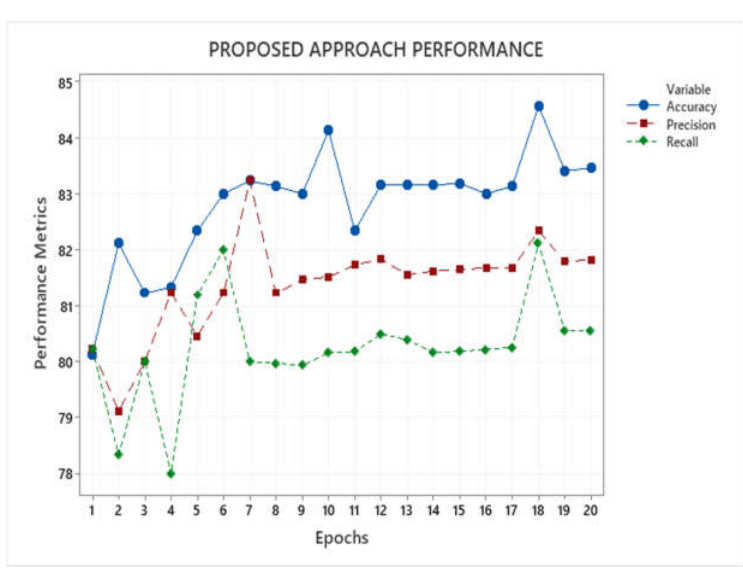
Figure 3. Performance of the deep learning approach on epoch tuning.